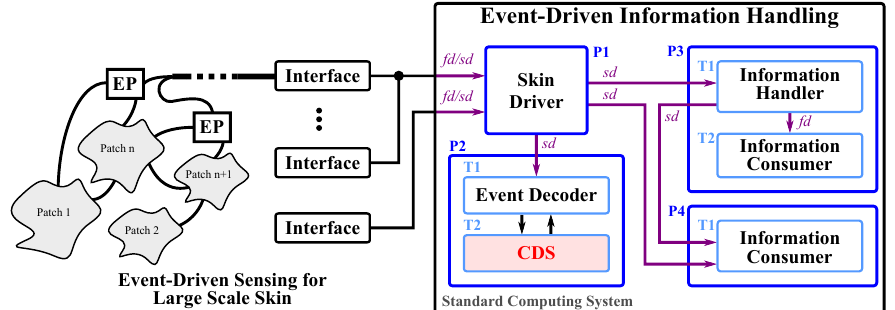
Figure 4. Event-driven information handlers exploiting the Signaled-Wakeup principle; fd are file descriptors, while sd are socket descriptors; Processes are denoted with P and threads with T; Process P2 contains a Clock-Driven Systems (CDS) and employs an event decoder to bridge from the event-driven to a clock-driven system; the endpoints (EP) between skin patches and interfaces refer to our realization of extended modularity in the interfaces; our new interface system differentiates the interfaces to main interfaces and interface satellites (EPs), see Reference